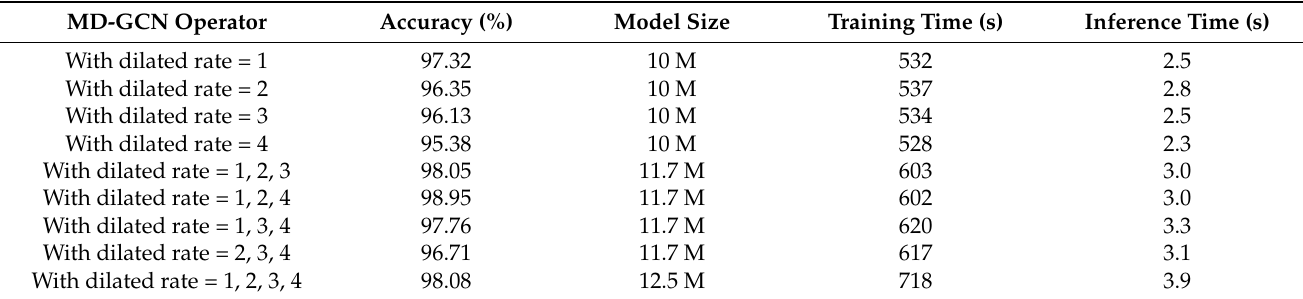
Table 1. The accuracy comparison of MD-GCN with different operators.